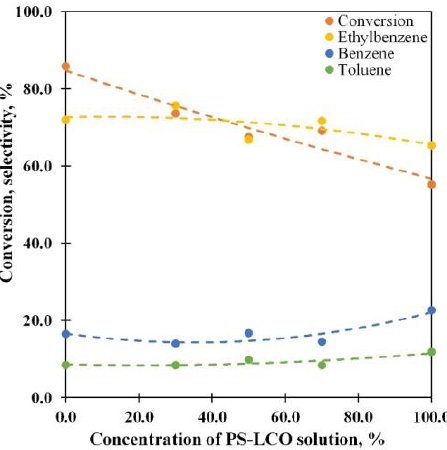
Figure 9. The PS conversion and main product selectivity vs. the PS-LCO solution concentration at 550 °C and WHSV 85 h − 1 for mixed 10% solutions of PS in LCO and HCO.